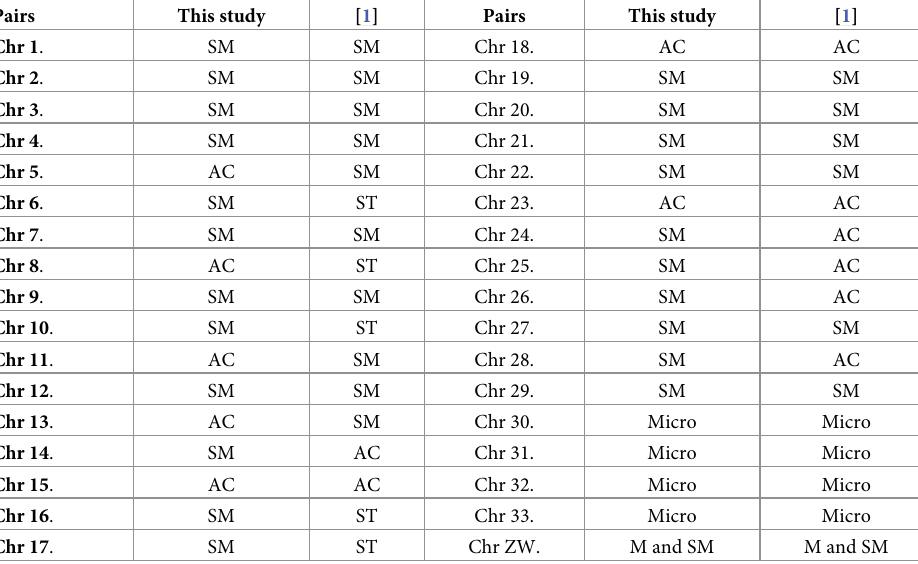
The results of comparative chromosome painting with whole chromosome probes of G . gal- lus showed a similar pattern to other birds of prey in the family Accipitridae, with a large reor- ganization of the syntenic groups homologous to the first five pairs of G . gallus . That is, each probe (GGA1—GGA5) corresponded to at least two distinct pairs (Fig 3). The most extreme examples are the fission of GGA1 into six pairs in STY, and GGA3 into four distinct pairs. These results are congruent with other birds of prey, considering that GGA1 can reveal synte- nic segments in four pairs ( Gypaetus barbatus , 2n = 60) to seven pairs ( Nisaetus nipalensis orientalis —NNI), while GGA3 is hybridized to four pairs in all species analyzed in this family. GGA10 are conserved syntenies, with only one signal for each pair.